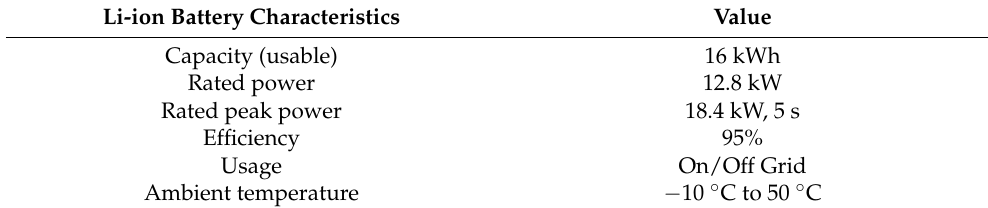
Table 3. Li-ion battery characteristics (LVS 16.0 f. BYD).